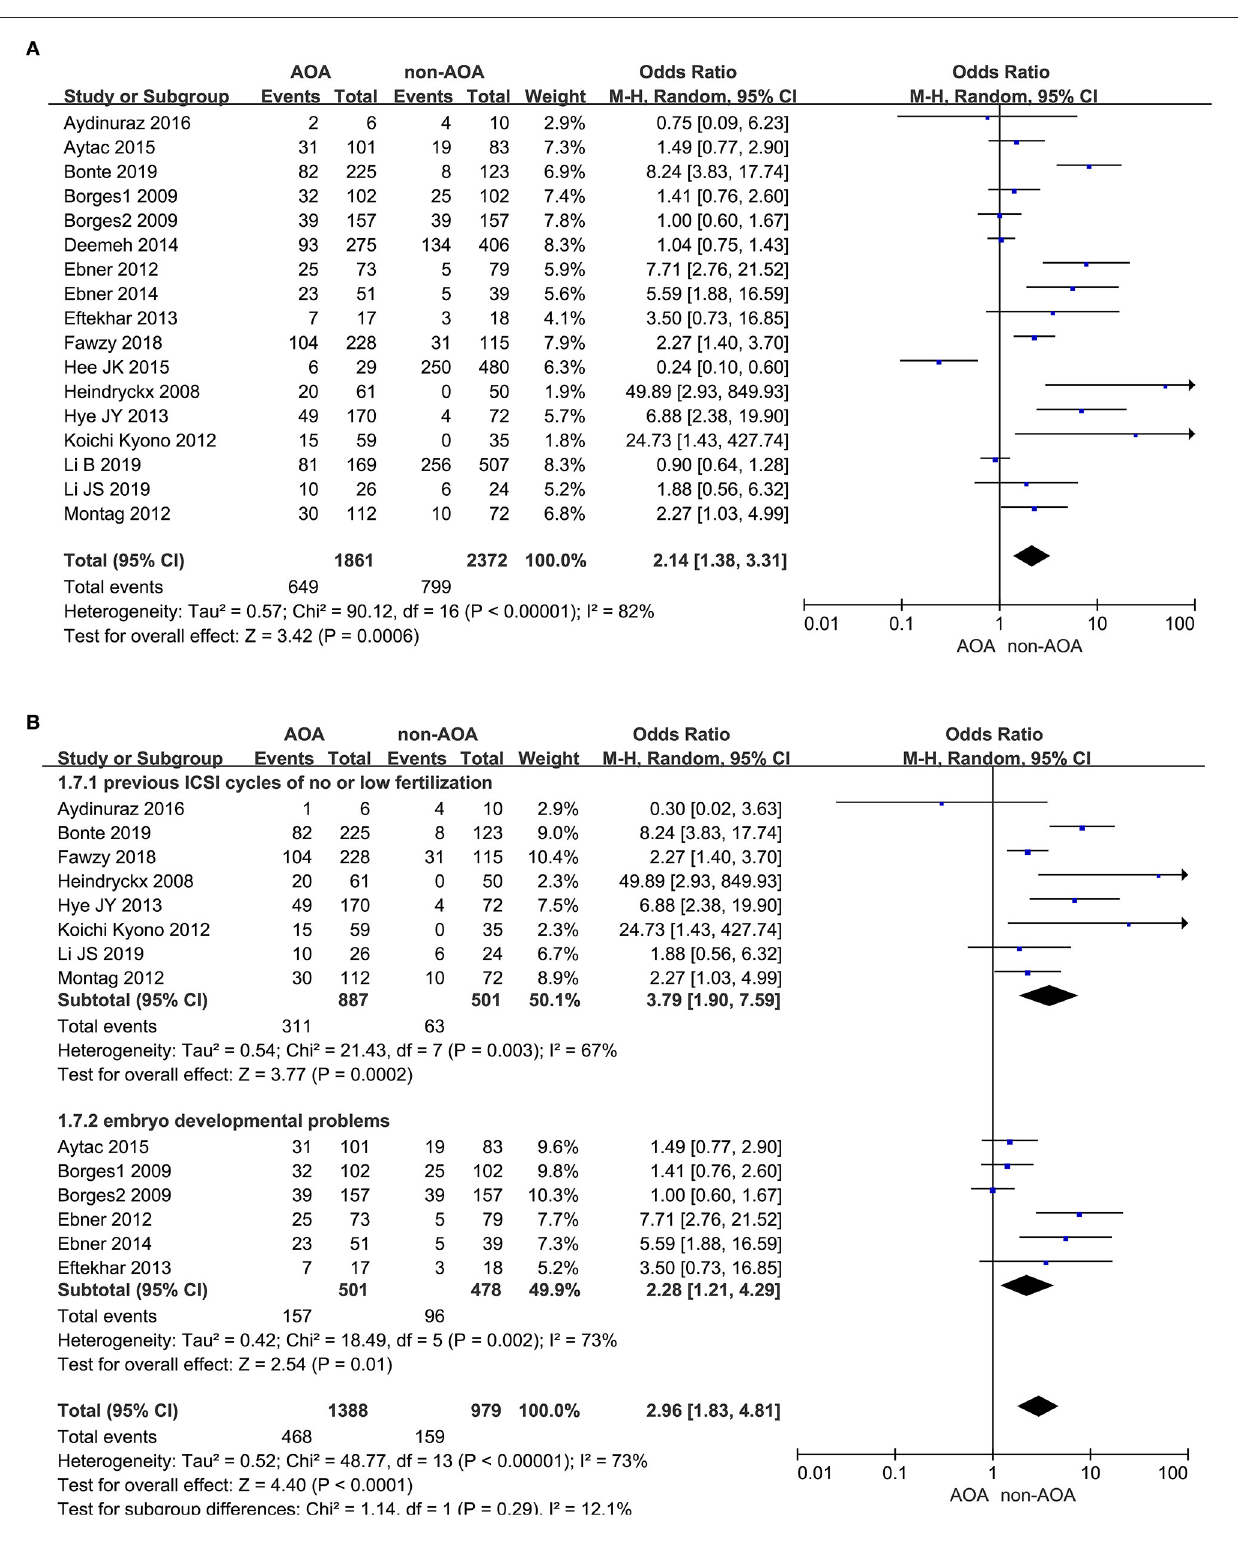
Frontiers in Physiology |